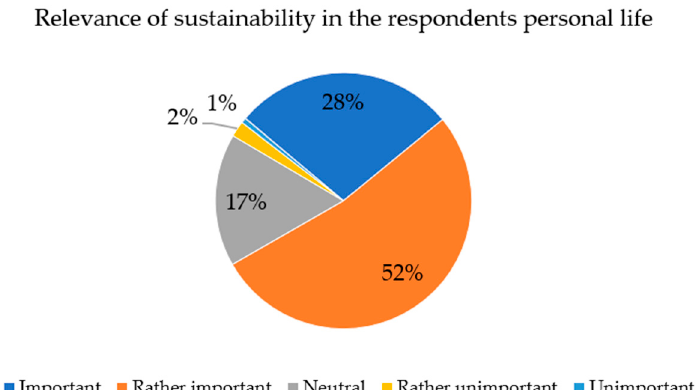
Figure 2. Relevance of sustainability in the respondents’ personal lives.